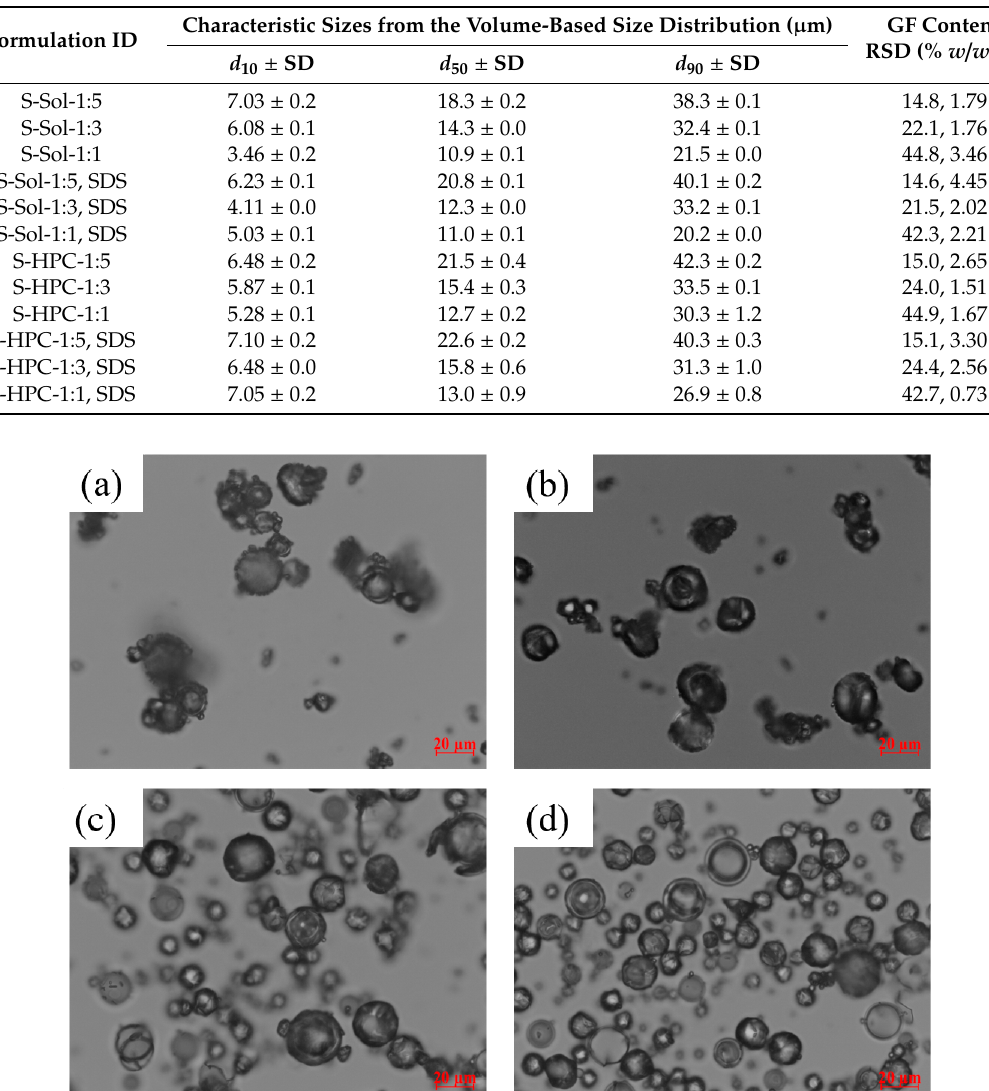
Figure 1. Light microscope images of the spray-dried particles prepared using the GF solution with a 1:3 GF:polymer mass ratio and 0.125% SDS/without SDS: ( a ) S-HPC-1:3, ( b ) S-HPC-1:3, SDS, ( c ) S-Sol-1:3, and ( d ) S-Sol-1:3, SDS. All images were taken at 50× magnification (scale bar: 20 µm).